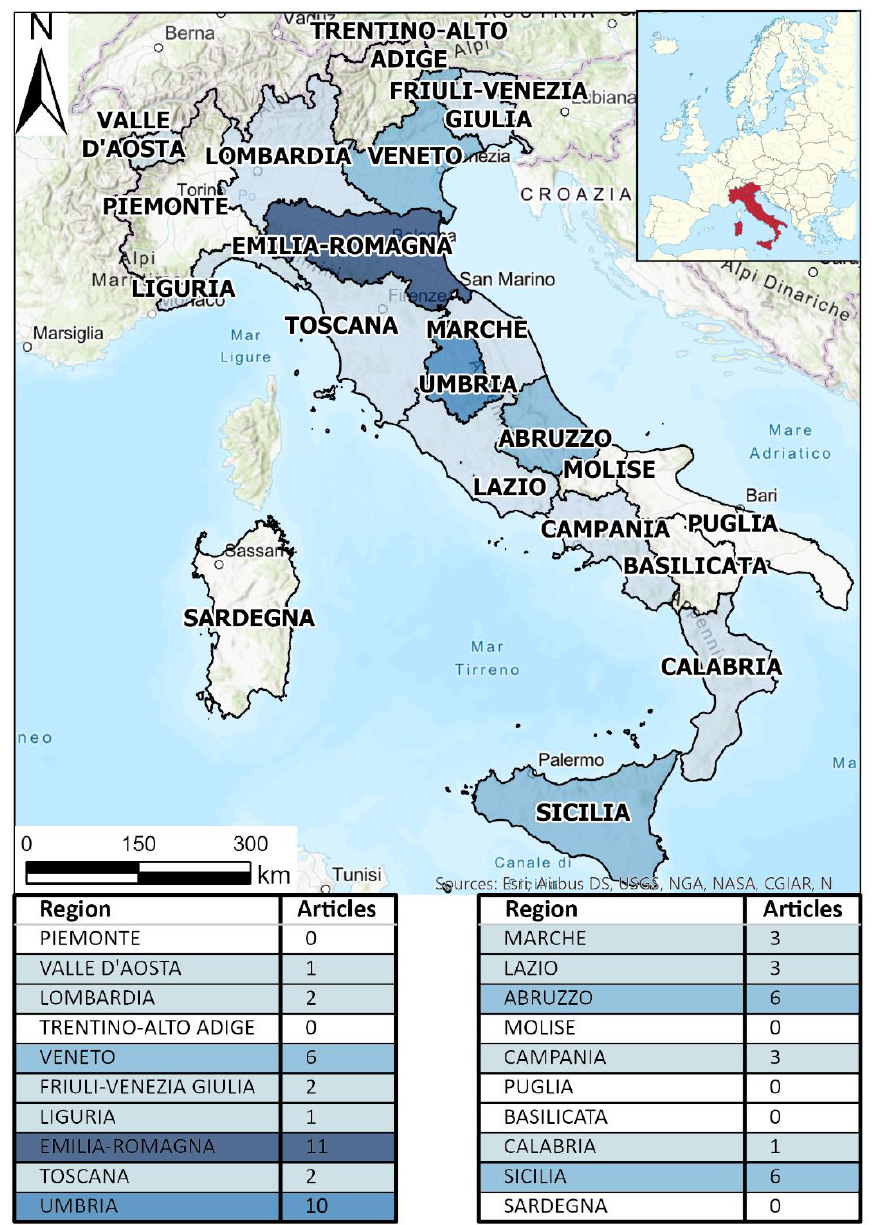
Figure 6. Spatial distribution per region in Italy.